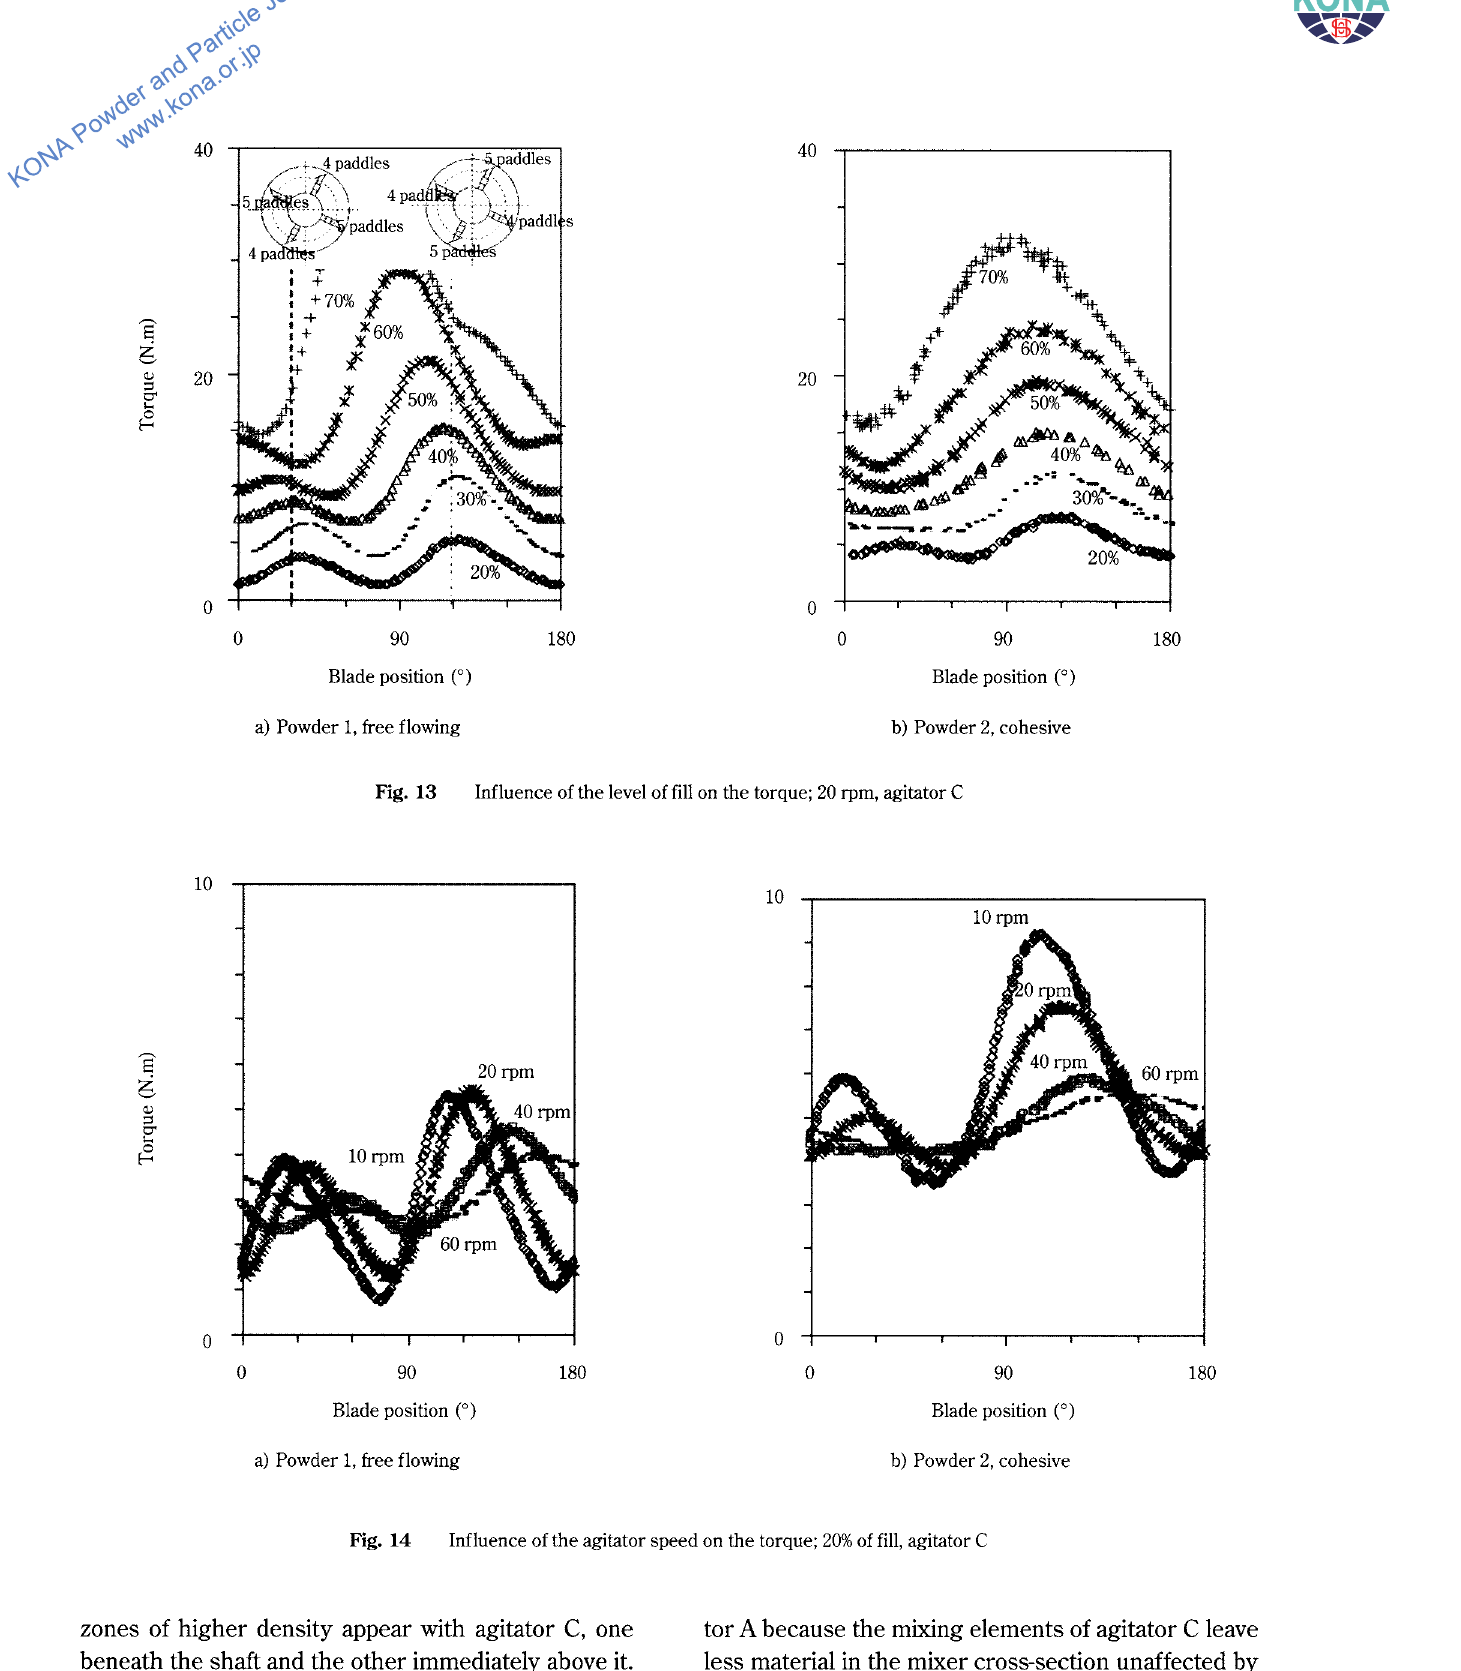
Influence of the agitator speed on the torque; 20% of fill, agitator